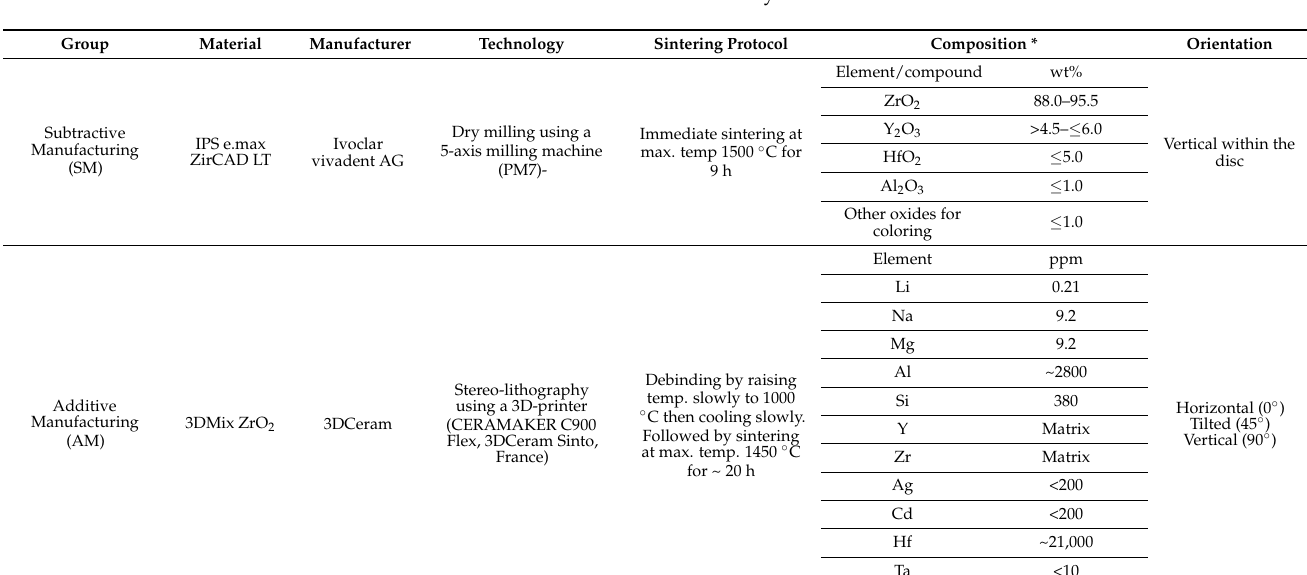
Table 1. Details of zirconia used in this